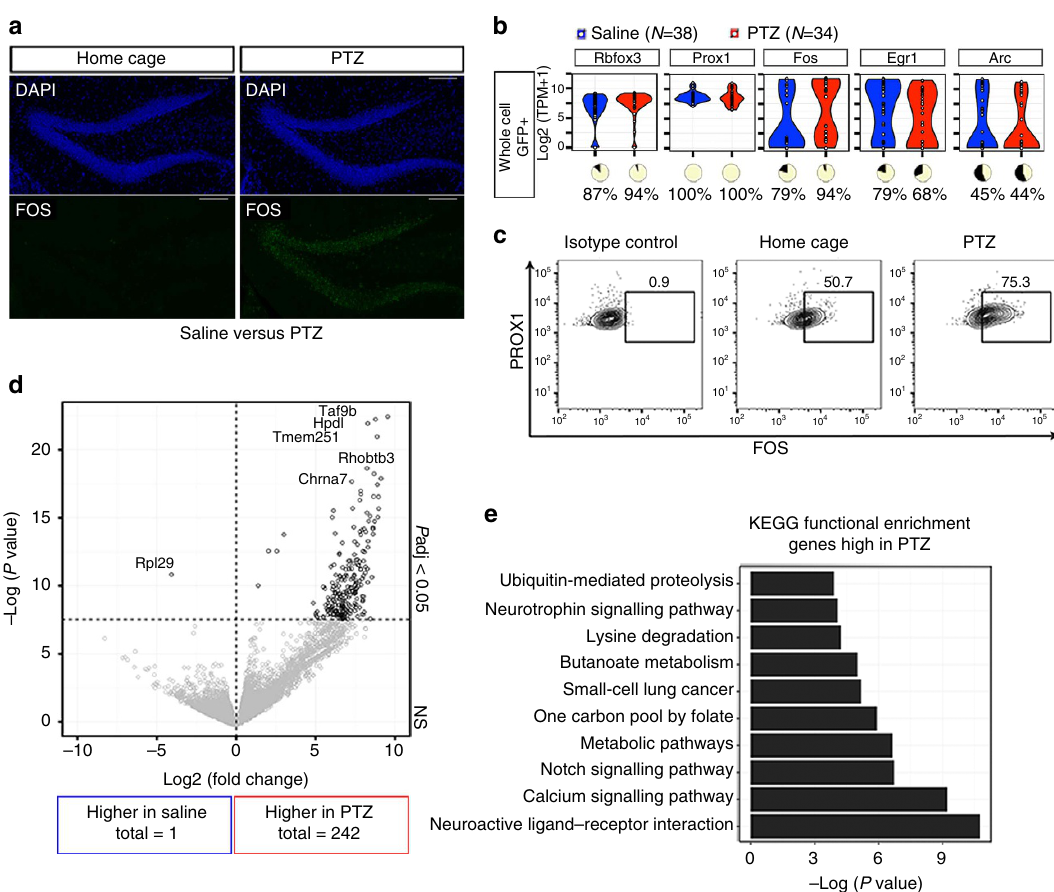
Figure 1 | Experience-independent induction of IEG expression in whole cells. ( a ) Confocal images of FOS protein expression in the DG of a HC mouse (left) and a PTZ-treated mouse (right). One hour after PTZ-induced seizure, FOS (green) expression was widespread throughout the granule cell layer, whereas expression under HC conditions was minimal. Scale bar, 100 m m. ( b ) log2(TPM þ 1) normalized RNA-seq values from dissociated saline-treated (blue, n ¼ 38) and PTZ-treated (red, n ¼ 34) whole-cells for neuronal marker Rbfox3 , DG marker Prox1 , and IEGs Fos , Egr1 and Arc . Pie charts indicate the proportion of samples with detectable gene expression (TPM 4 1; yellow). ( c ) Representative FACS plots showing FOS protein expression in PROX1 þ live (Zombie -) single whole-cells isolated from the hippocampus of PTZ-treated and HC mice, n ¼ 2. FOS protein expression was observed in both PTZ-treated and HC animals. ( d ) Gene expression comparison of activated saline-treated and PTZ-treated whole cells. Dots to the left of zero represent genes with higher expression in saline, those to the right represent genes with higher expression in PTZ whole cells. EdgeR was used for differential expression analysis. ( e ) Functional enrichment of genes high in PTZ-treated whole cells using a modified Fisher’s exact test (EASE score, DAVID bioinformatics 69